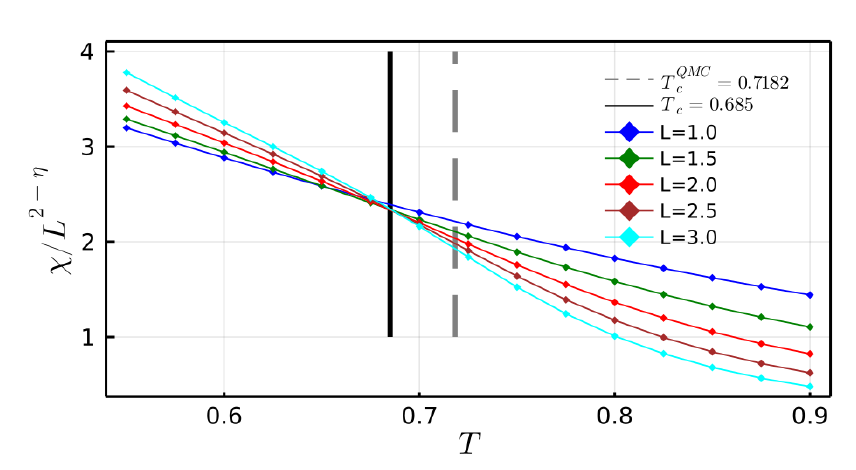
Figure 8: PMFRG ( (cid:96) = 1) results for the ferromagnetic Heisenberg model on the (cid:39) 0.685 in good agreement pyrochlore lattice indicating a phase transition at T c = 0.7182 from Ref. [ 53 ] with the QMC value T QMC c